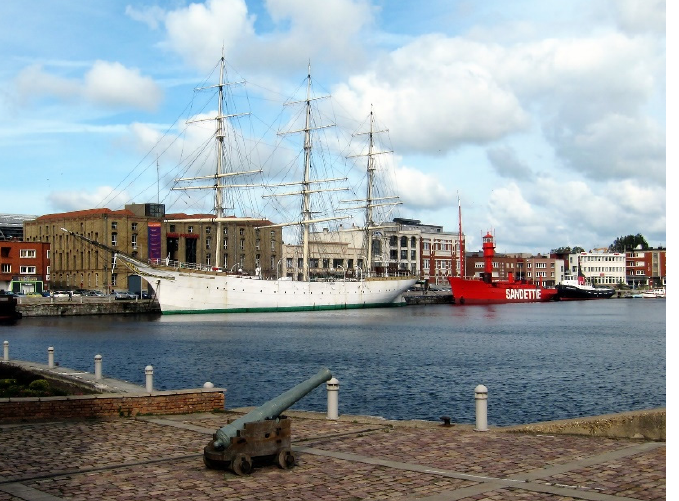
Figure 3. Port Museum of Dunkirk (Musée Portuaire de